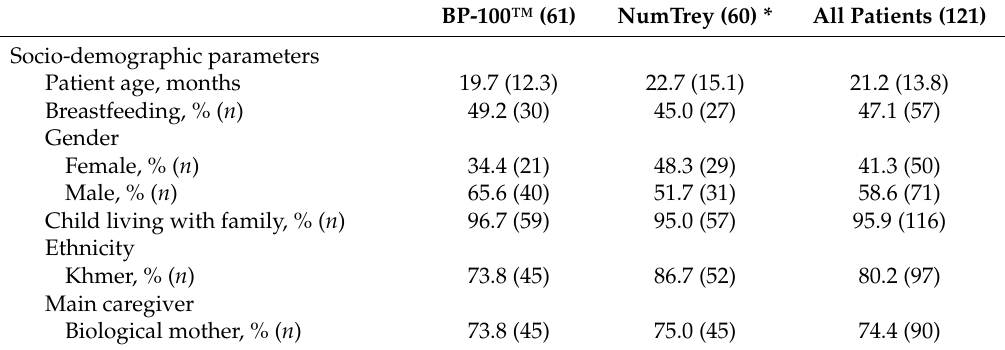
Table 3. Baseline characteristics of the patients allocated to BP-100™ or NumTrey based on randomization.